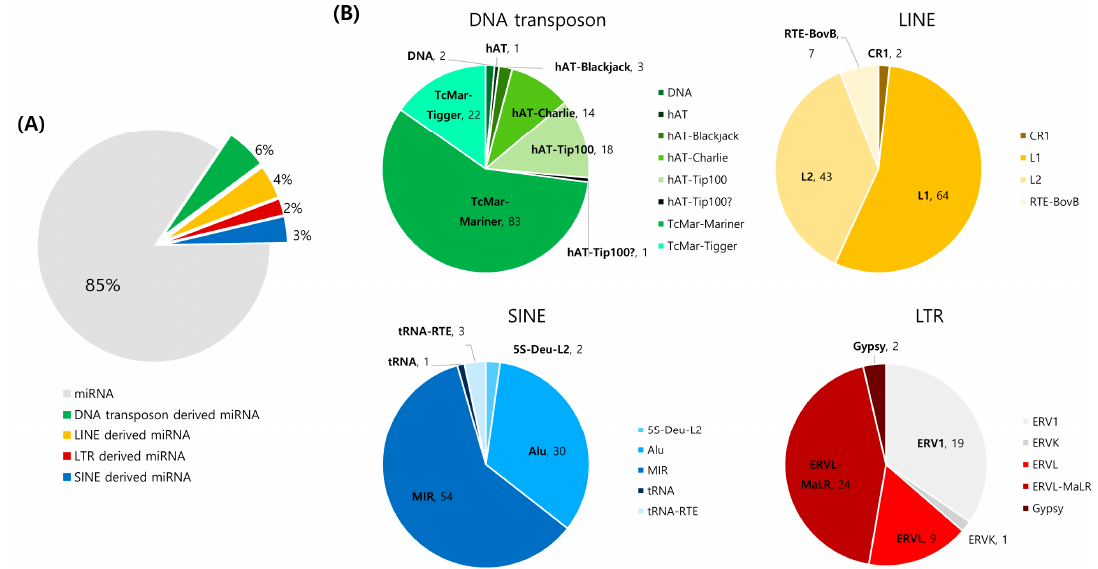
Figure 3. Percentage and composition of MDTEs. ( A ) The proportion of MDTEs in total miRNA and the distribution of TE subclasses from which miRNAs are derived; ( B )The number of TE superfamilies that generate miRNAs from each TE subclasses, DNA transposon, LINE, SINE, and LTR.